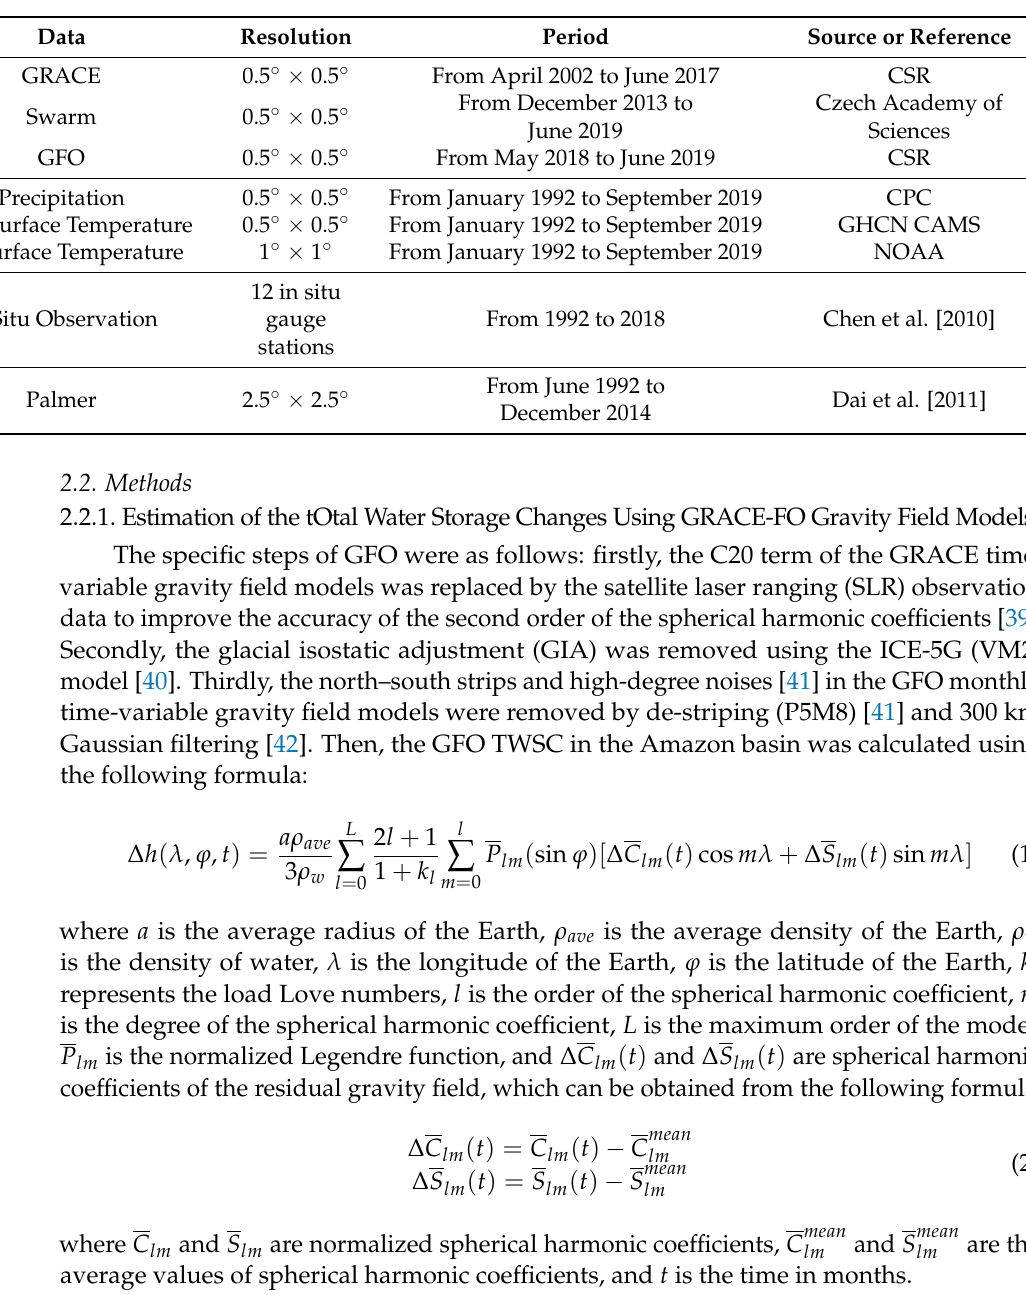
Table 2. Data used in this